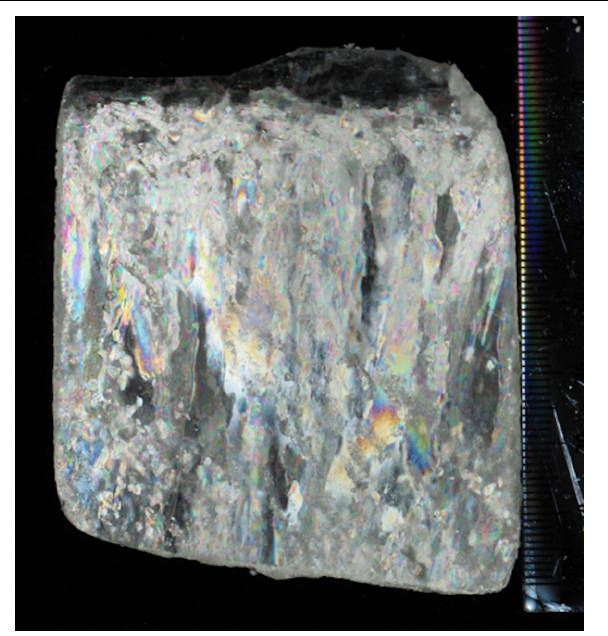
FIGURE 2 | An ice section (0.5 cm thick) of artificial sea ice from the low-Fe ice tank. An ice block (5 cm × 10 cm × 5.5 cm) was sectioned to 0.5 cm with a band saw at − 20 ◦ C. After planning with a microtome blade, the thick section was photographed between cross-polarized filters.